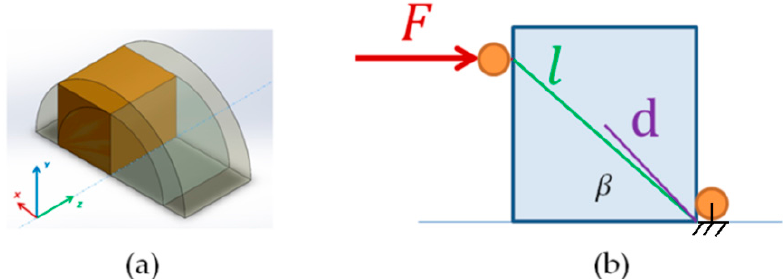
Figure 3. ( a ) 3D representation of the overturning movement around an axis. ( b ) 2D simplification of the overturning problem, where “ F ” is the force applied, “ l ” is the distance from the point of application of the force to the turning axis, “ β ” is the angle between “ l ” and the horizontal and “ d ” is the distance from the geometrical center to the turning axis.